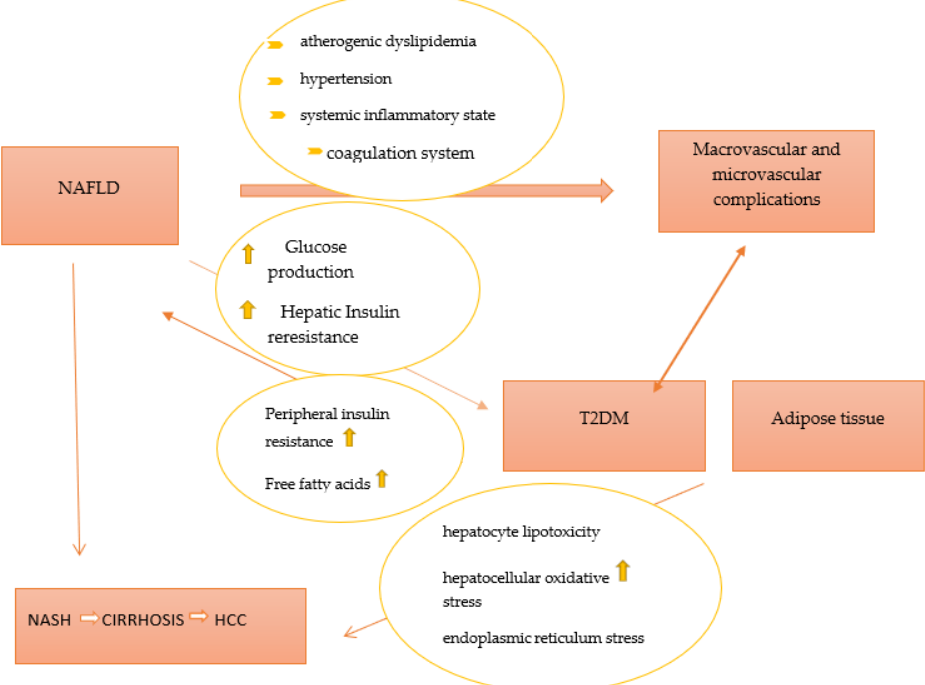
Figure 1. The pathophysiological link between NAFLD and T2DM. Abbreviations: T2DM—type 2 diabetes mellitus; NAFLD—non-alcoholic fatty liver disease; NASH—non-alcoholic steatohepatitis; HCC—hepatocellular carcinoma.